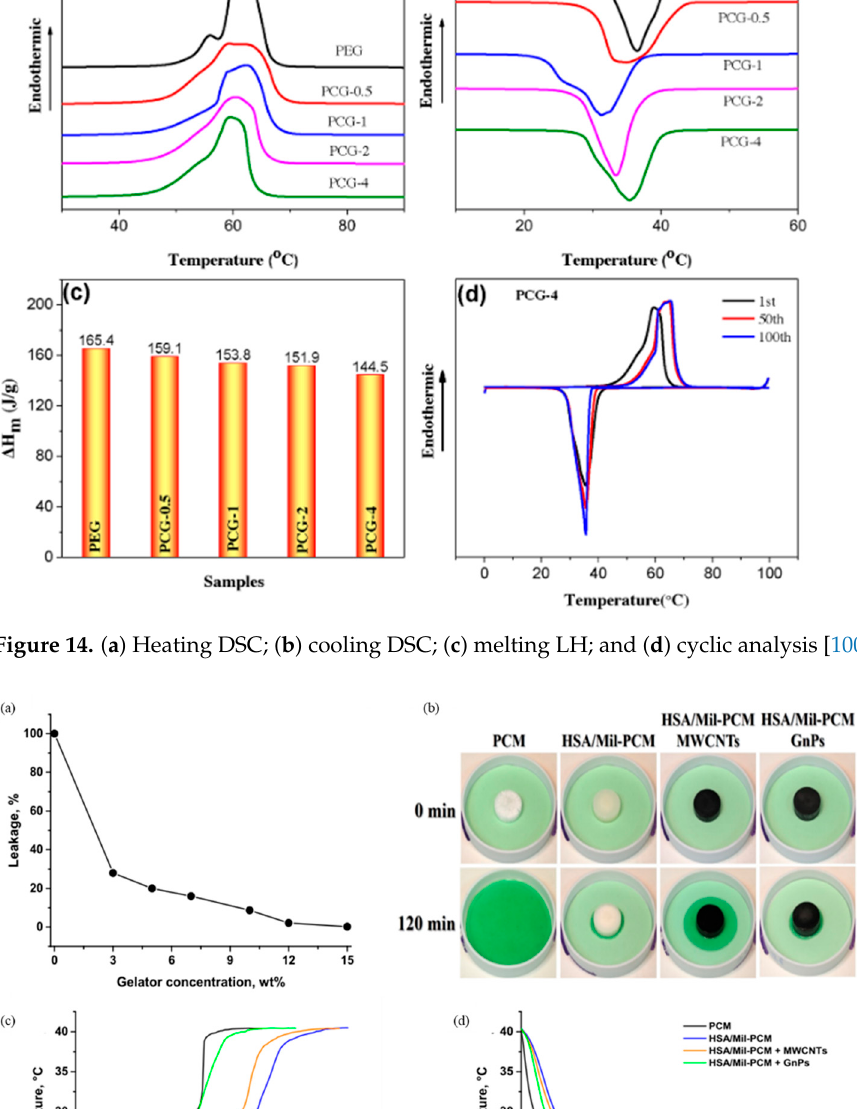
Figure 13. Sample preparation approach followed by Wei et al. [100].